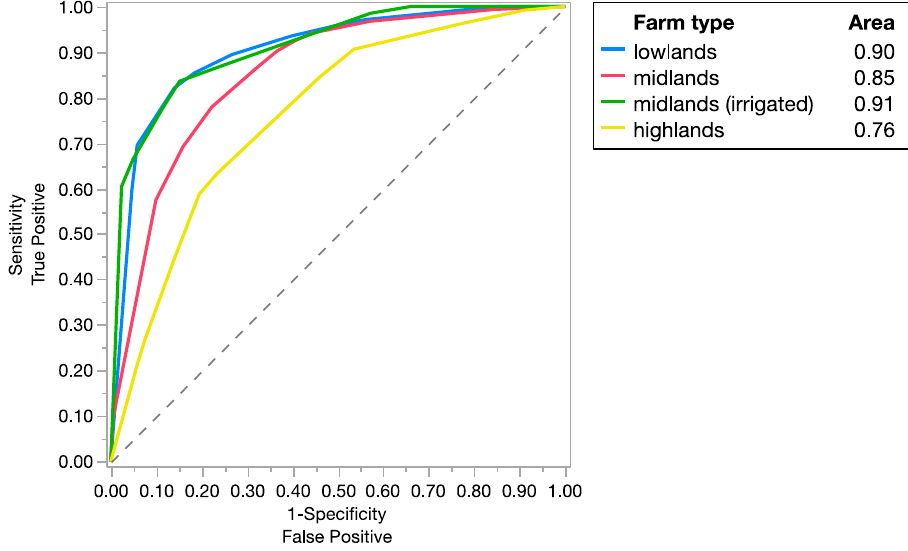
Figure A2. Receiver operating characteristic curves for the decision tree model. Areas under the curves show model partition accuracy using the four priority indicators after 10 decision steps.